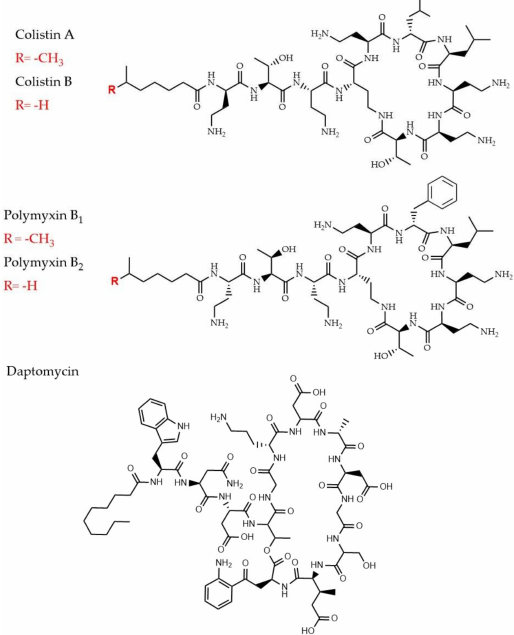
Figure 6. Chemical structures of cyclic lipopeptides, polymyxin (B 1 and B 2 ), colistin (A and B), and daptomycin, are shown. R = CH 3 is polymyxin B1 and R = H is polymyxin B2. Similarly, for colistin, R = CH 3 is colistin A and R = H is colistin B. The ring in daptomycin consist of 10 varied amino acids and the tail contains di ff erent amino acid composition along with longer carbon chain (10